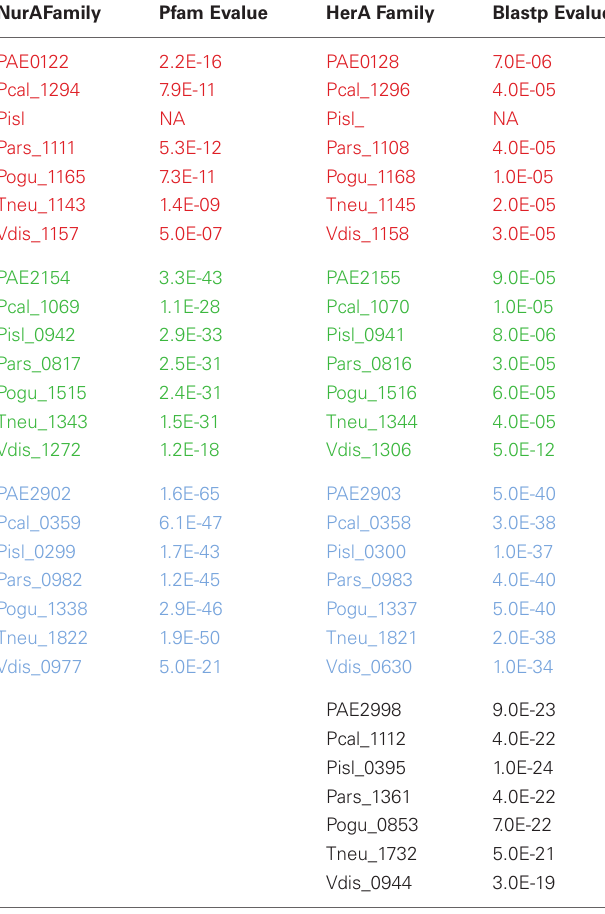
Table A2 | NurA and HerA paralogs in Pyrobaculum